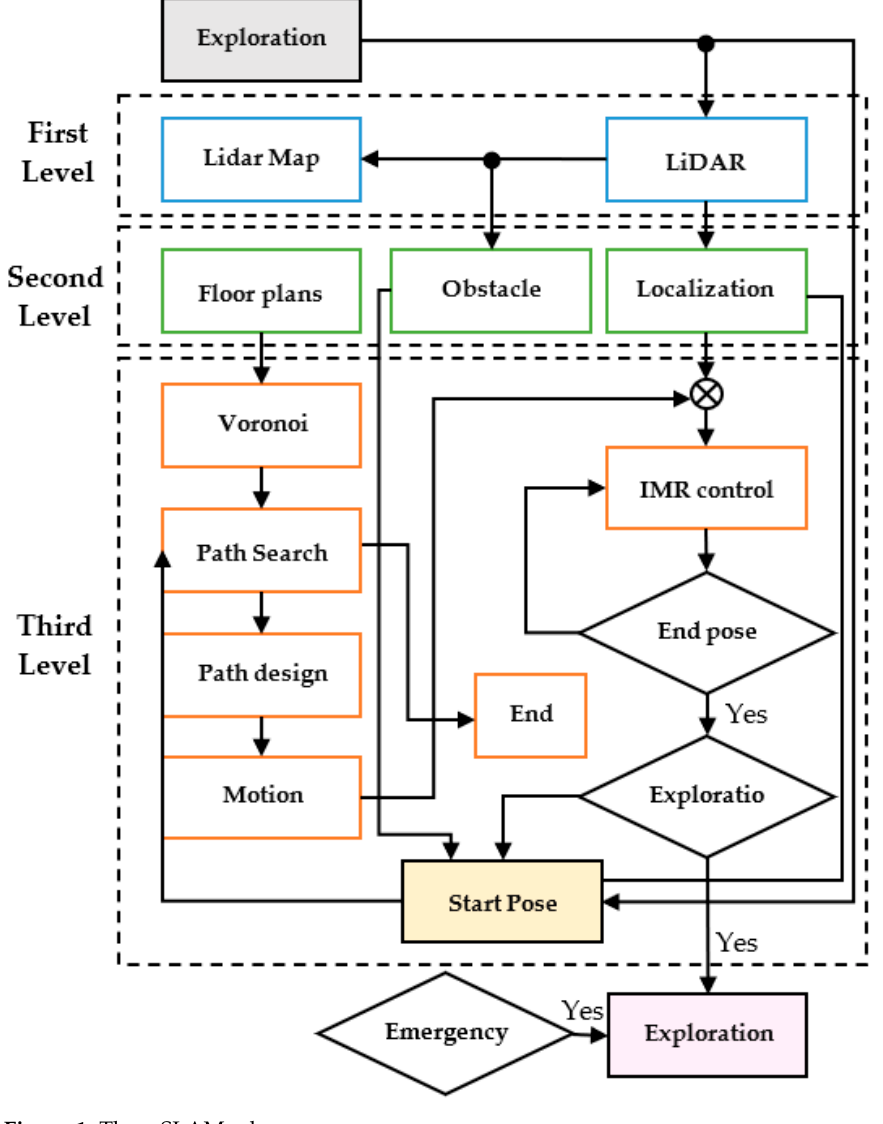
Figure 1. The e-SLAM scheme.